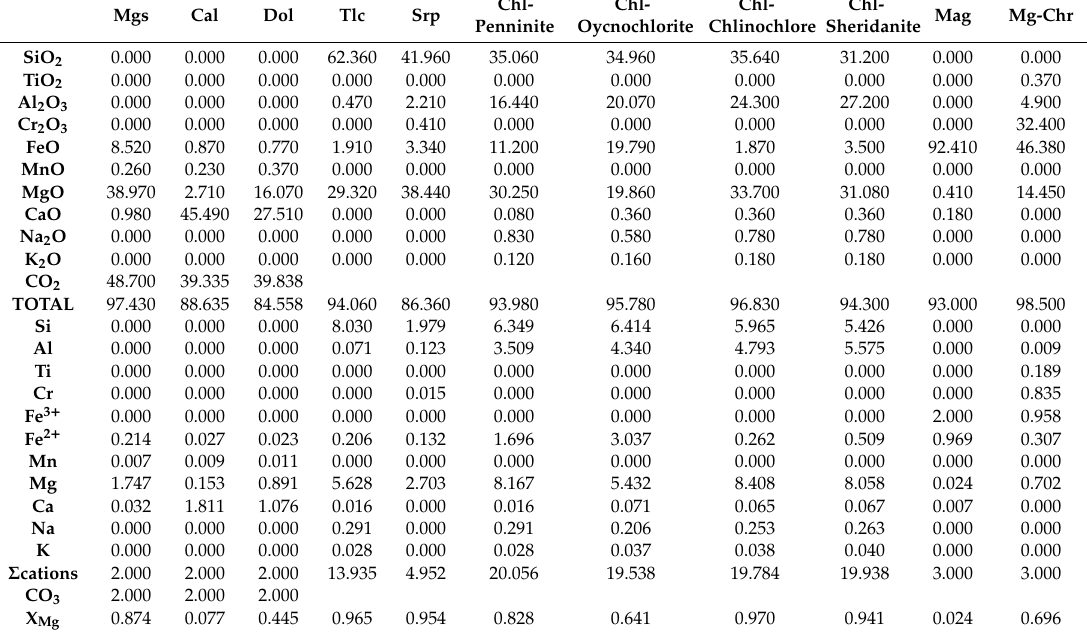
Table 2. Representative mineral analyses in serpentinite gouge rock. Srp = serpentine; Tlc = talc; Mgs = magnesite; Mag = magnetite; Mg-Chr = magnesium-chromite; Cal = calcite; Dol = dolomite; Chl = chlorite, four types of chlorite (Penninite, Pycnochlorite, Chlinochlore and Sheridanite) have been detected. Structural formulae of Mag and Mg-Chromite have been calculated on the basis of 4 oxygens and 3 cations. Apart from the last two oxides, for all the minerals the total amount of Fe has been considered only as Fe 2 + CO 3 has been